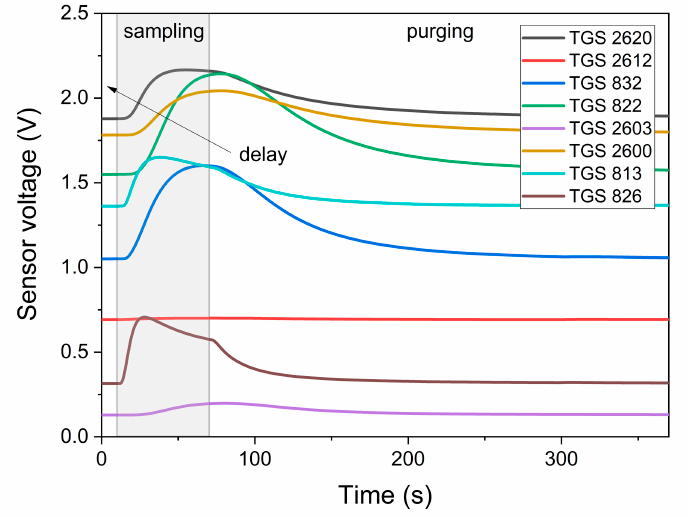
Figure 2. An example of the real e-nose responses when detecting a BOP tea sample.